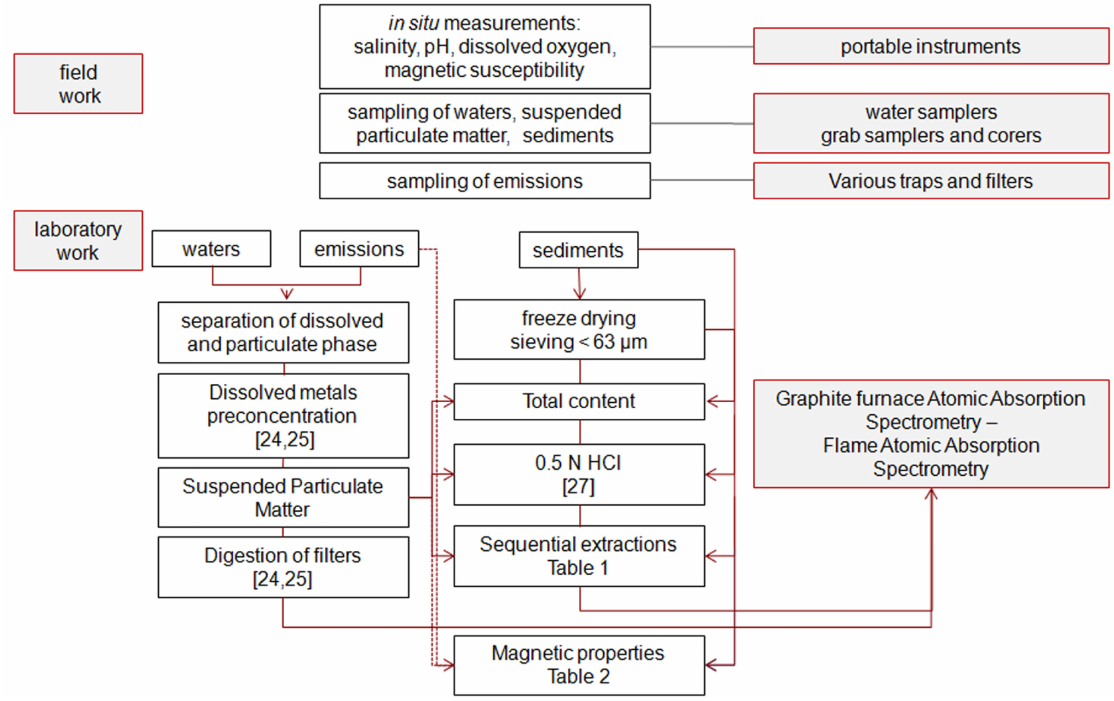
Figure 1. Field and laboratory procedures followed in trace metals geochemical studies.